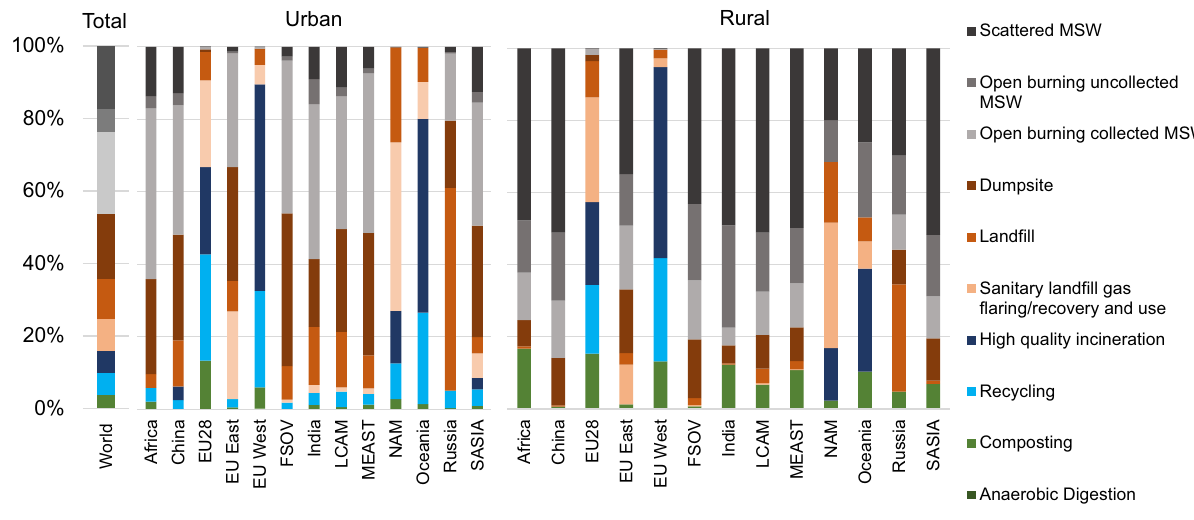
Fig. 3 Municipal solid waste management in 2015. Urban areas in low-middle income regions have increased municipal solid waste (MSW) collection rates in last years. However, MSW treatment has not improved at the same pace, hence most of the waste is dumped, scattered or openly burned. Collection rates in rural areas in low-middle income regions are just about 35 – 45%. In general, high-income regions have established suitable MSW treatment systems in both urban and rural areas. North America (NAM), East Europe (EUEast), West Europe (EUWest), Latin America (LCAM), South Asia (SASIA), Former Soviet Union (FSOV), Middle East